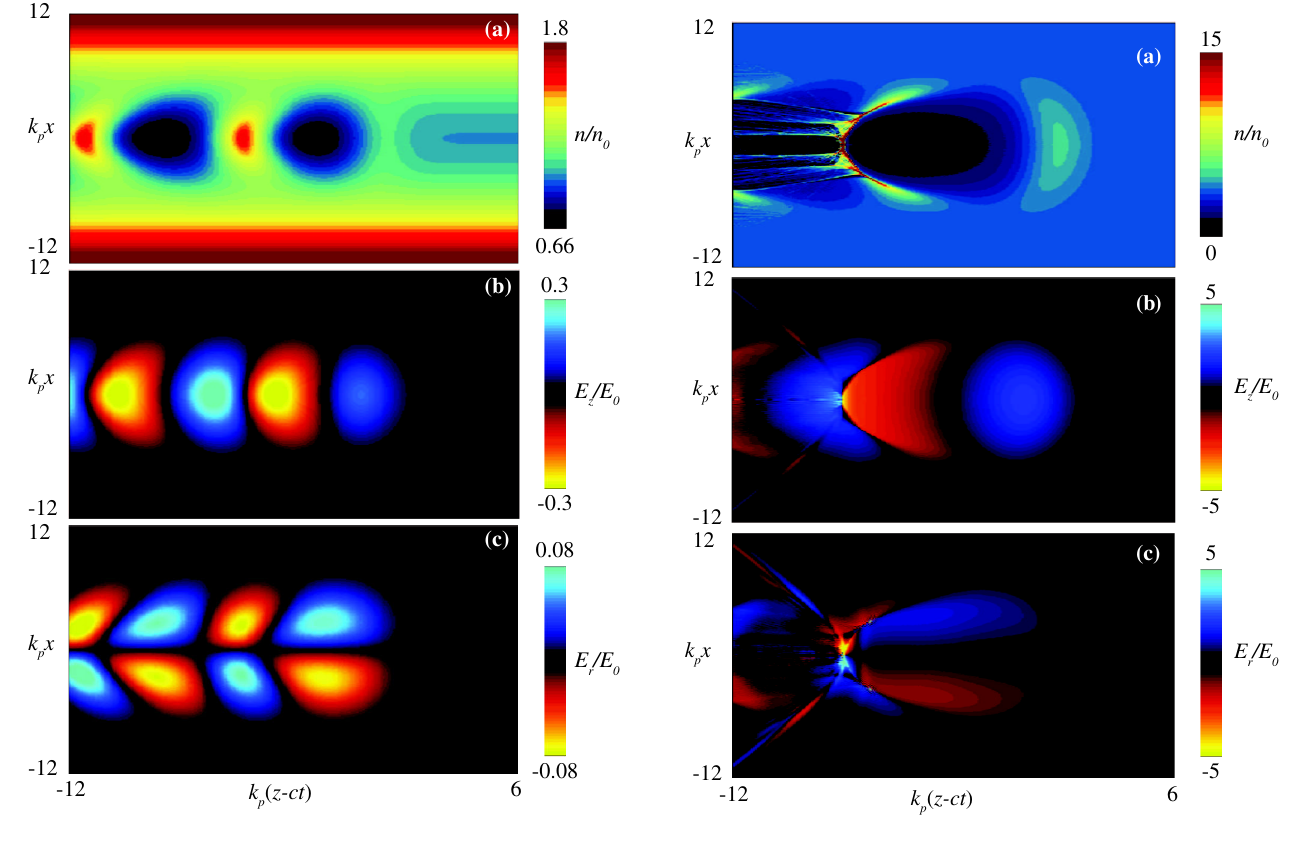
, (b) axial electric field 0 . Profile of the normal- 0